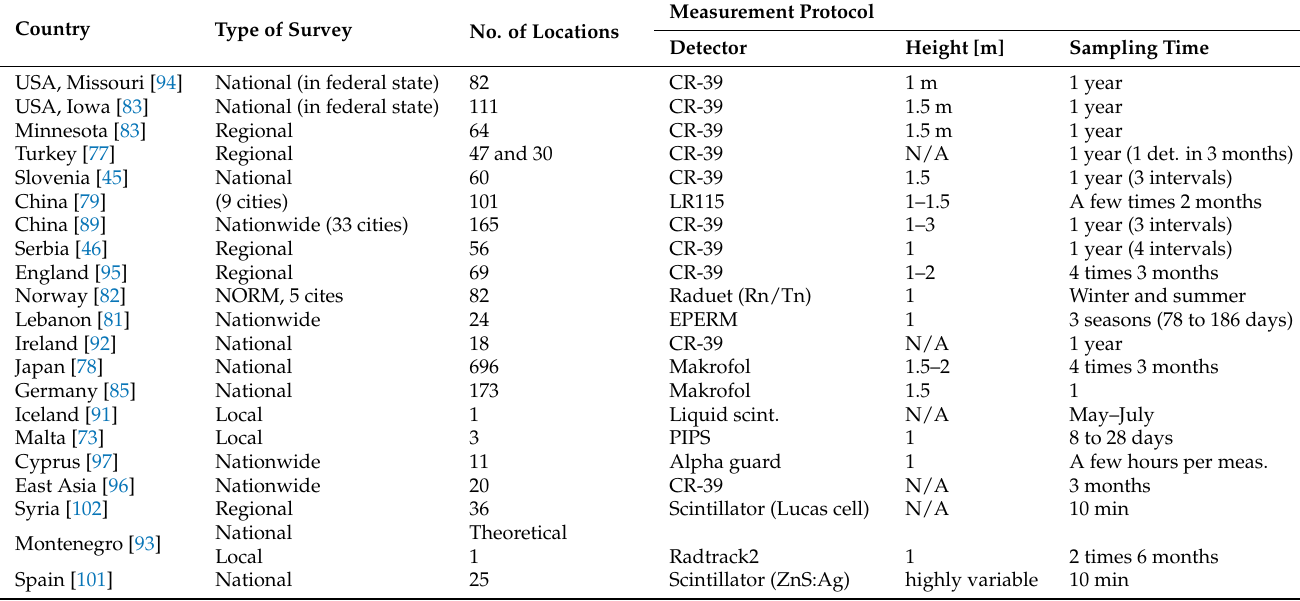
Table 1. Properties of outdoor radon surveys